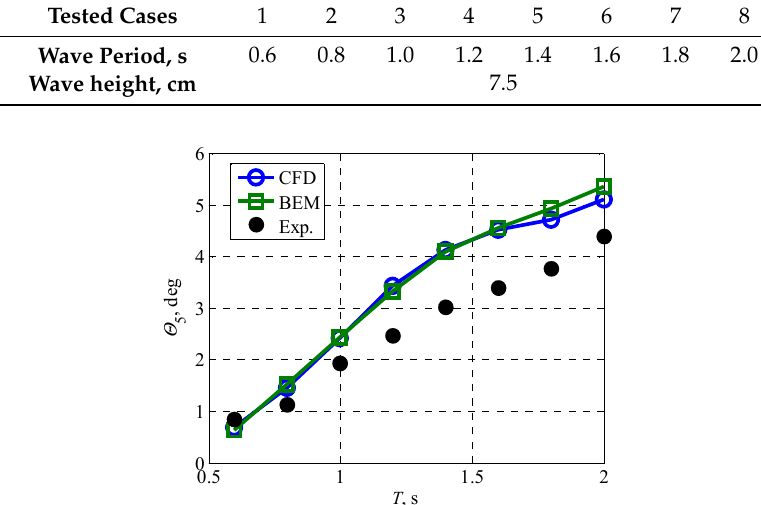
Figure 10. Comparison of pitch angular displacement amplitude as a function of wave period between CFD, BEM and experimental results at H = 0.075 m.